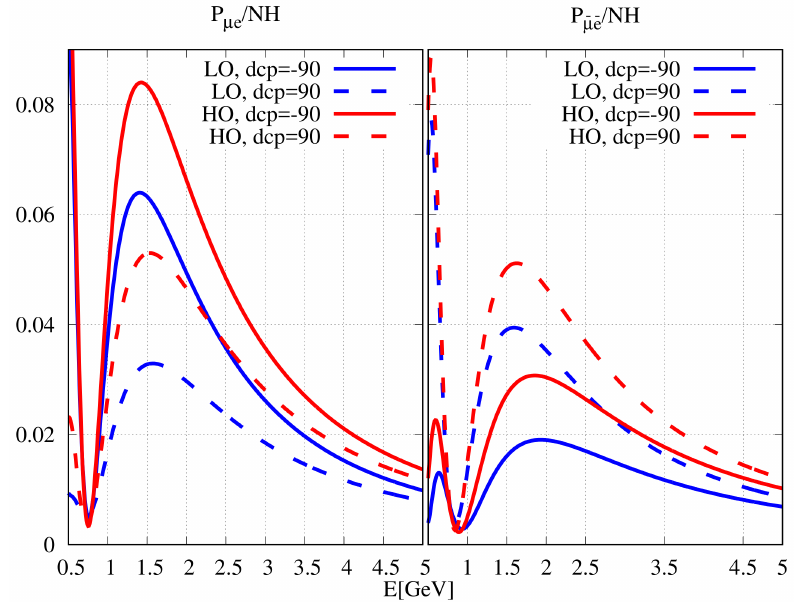
Figure 3. P µ e as a function of neutrino energy for the NO ν A baseline. The left ( right ) panel is for ν (¯ ν ). The plots have been drawn for different possible δ CP values between − 180 ◦ and 180 ◦ . The sin 2 2 θ 13 value is 0.089. The value of sin 2 θ 23 is 0.41 (0.59) for LO